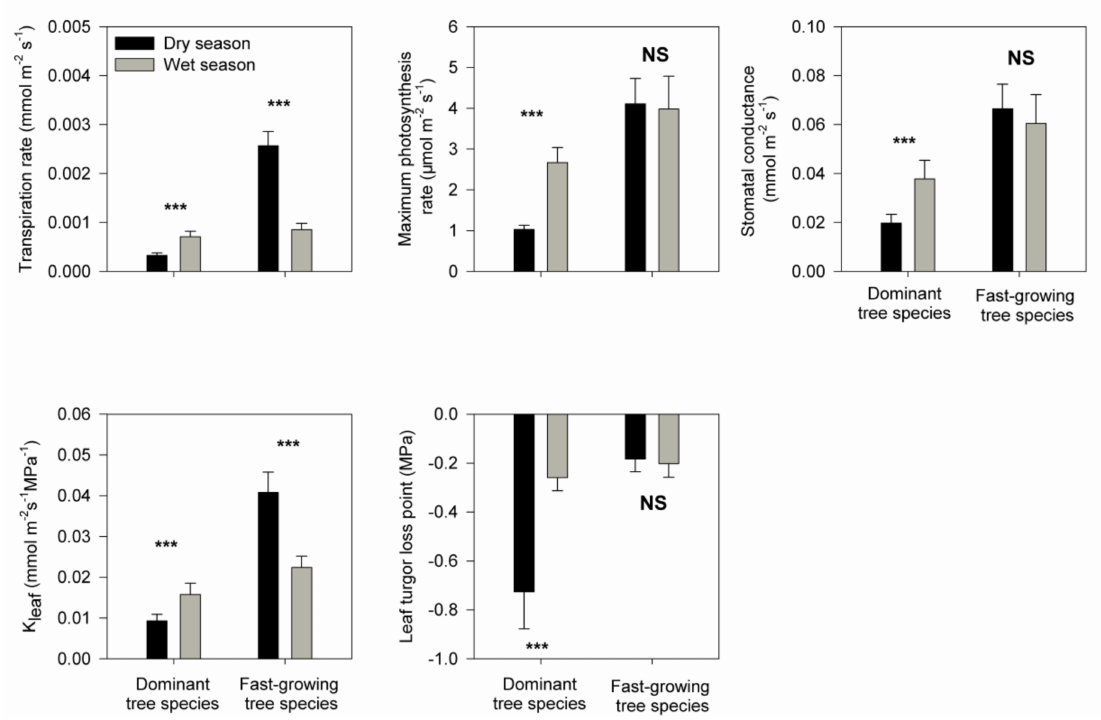
Figure 3. Differences in each of the five hydraulic traits (transpiration rate (TR), maximum photosynthesis rate (Amass), stomatal conductance (SC), leaf hydraulic conductivity (LHC), and leaf turgor loss point (TLP)) between the wet and the dry seasons for the fast-growing species used for reforestation as well as the dominant slow-growing species in the adjacent undisturbed tropical rain forest. *** indicates p < 0.05 and NS (nonsignificant) indicates p > 0.05 based on a generalized linear mixed e ff ect model with Poisson error family. Bars indicate the mean values, and error bars denote standard